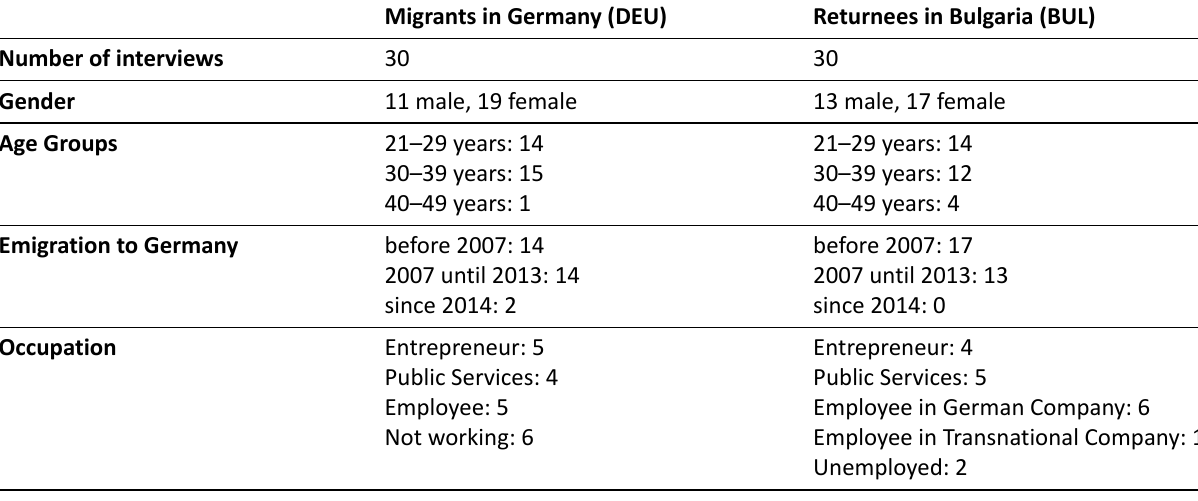
Table 1. Characterization of the interviewed